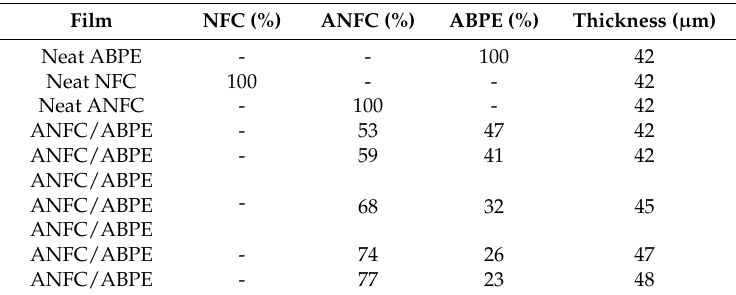
Table 1. The composition and thickness of the films.